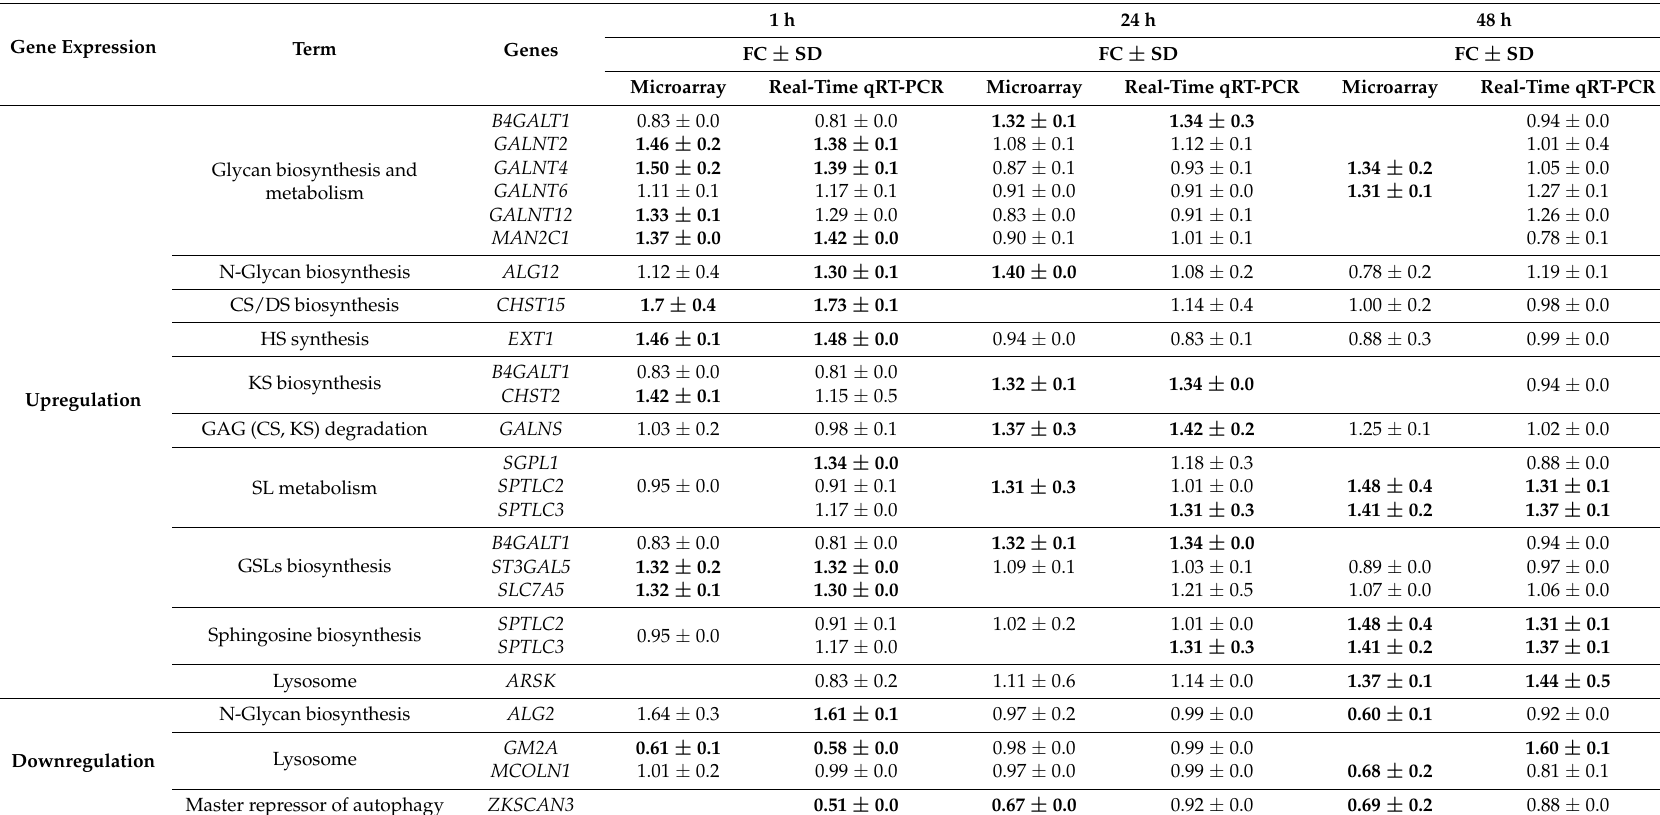
Table 3. Expression patterns of GAG metabolism- and lysosome-associated genes in HDFa treated with 0.05% DMSO for 1, 24 and 48 h, identified in microarray and real-time qRT-PCR analyses (bolded are values of FC ≤ 0.7 and FC ≥ 1.3, n = 3, with the p -value <